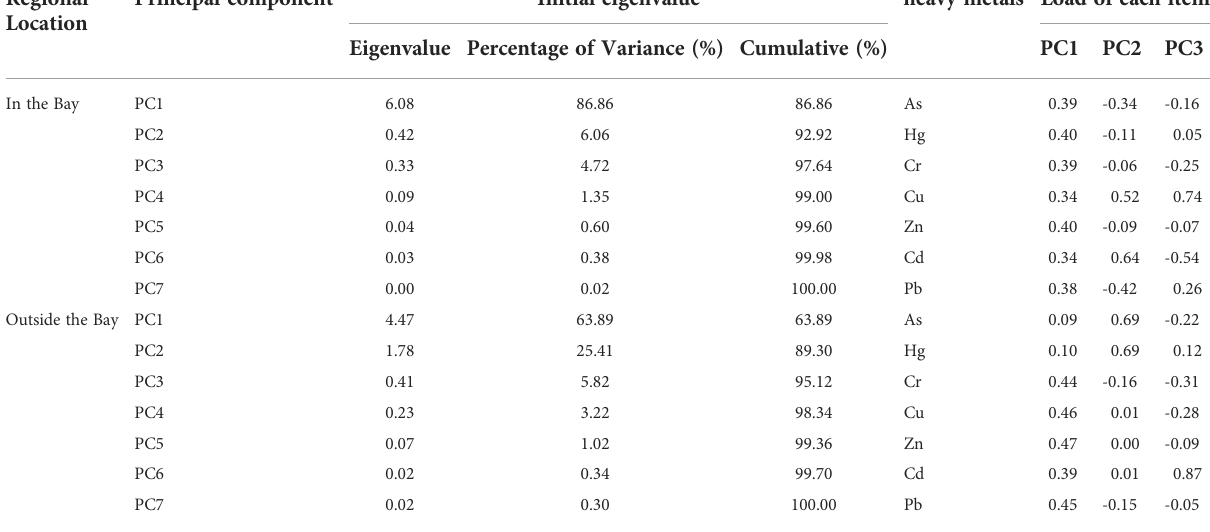
TABLE 6 Principal component analysis results of heavy metals in Daya Bay sediments. Regional Principal component Initial eigenvalue heavy metals Load of each Location